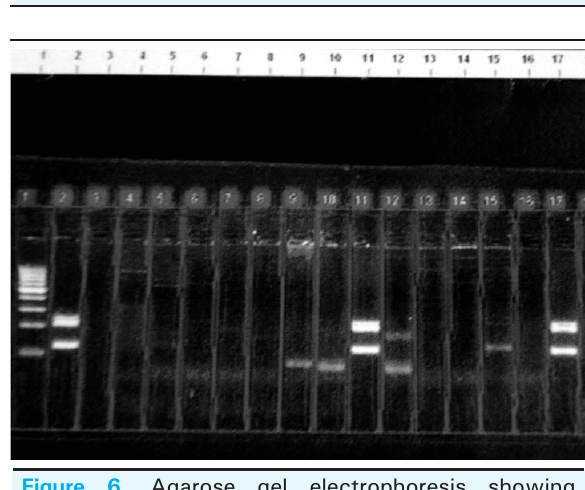
figure 5. Photomicrograph showing a caseating epithelioid cell granuloma in the ovary [HandE x400].